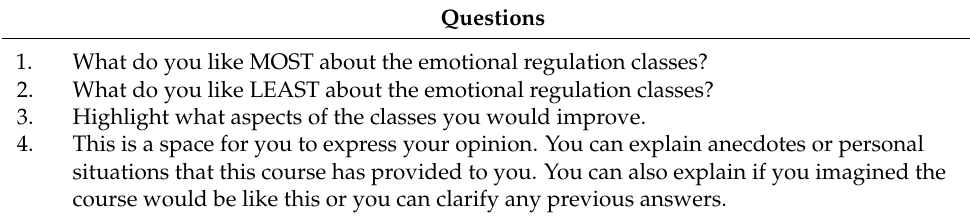
Table 3. Qualitative questions addressed in the satisfaction survey 2 .